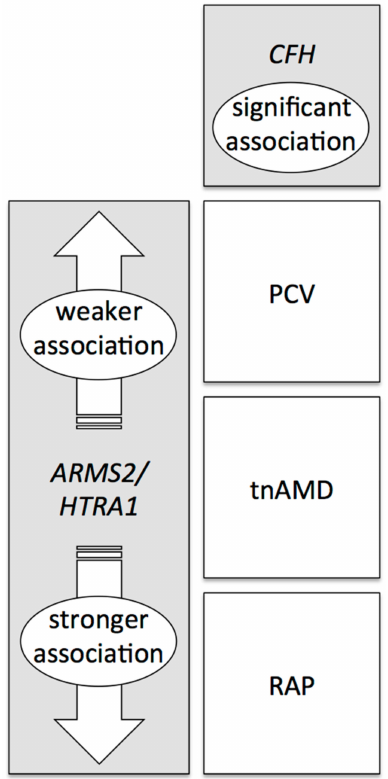
Figure 2. Association of CFH and ARMS2 / HTRA1 with subtypes of age-related macular degeneration (AMD). The association of ARMS2 / HTRA1 is weaker for polypoidal choroidal vasculopathy (PCV) and stronger for retinal angiomatous proliferation (RAP) than typical neovascular AMD (tnAMD). CFH does not show such significant di ff erences in its e ff ect size across the three neovascular AMD